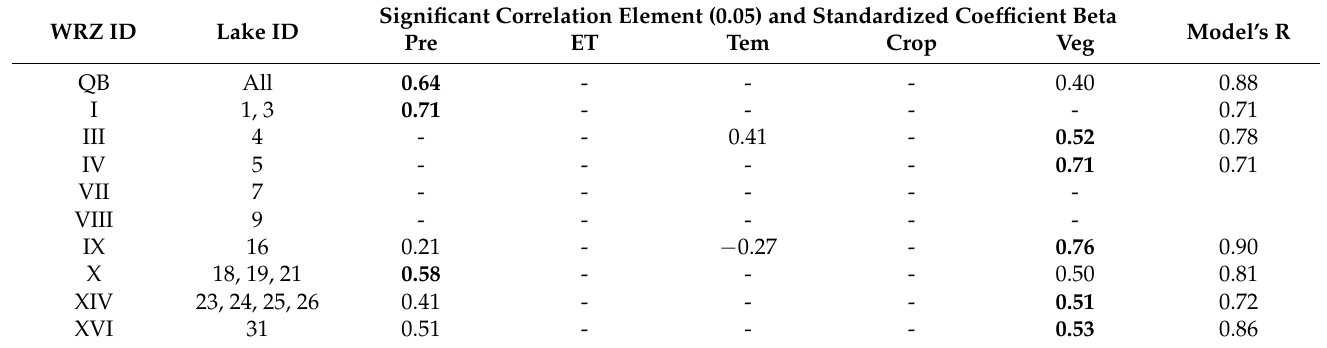
Table 9. Significant correlation elements and their standardized coefficients of lake storage